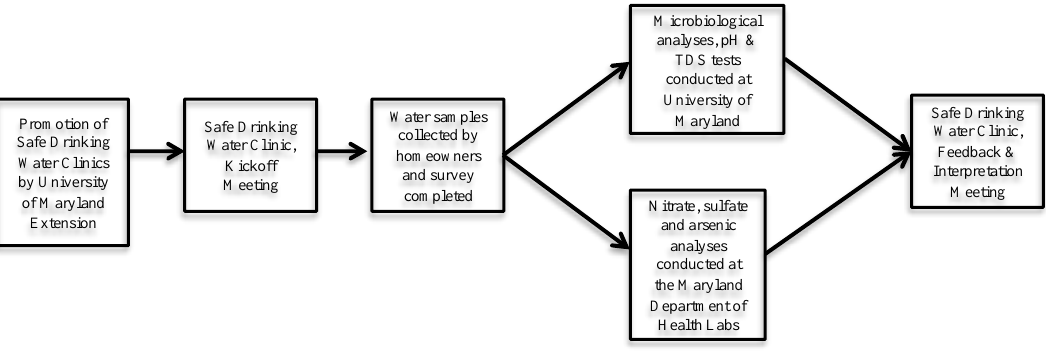
Figure 2. University of Maryland safe drinking water clinic approach. TDS — total dissolved solids.